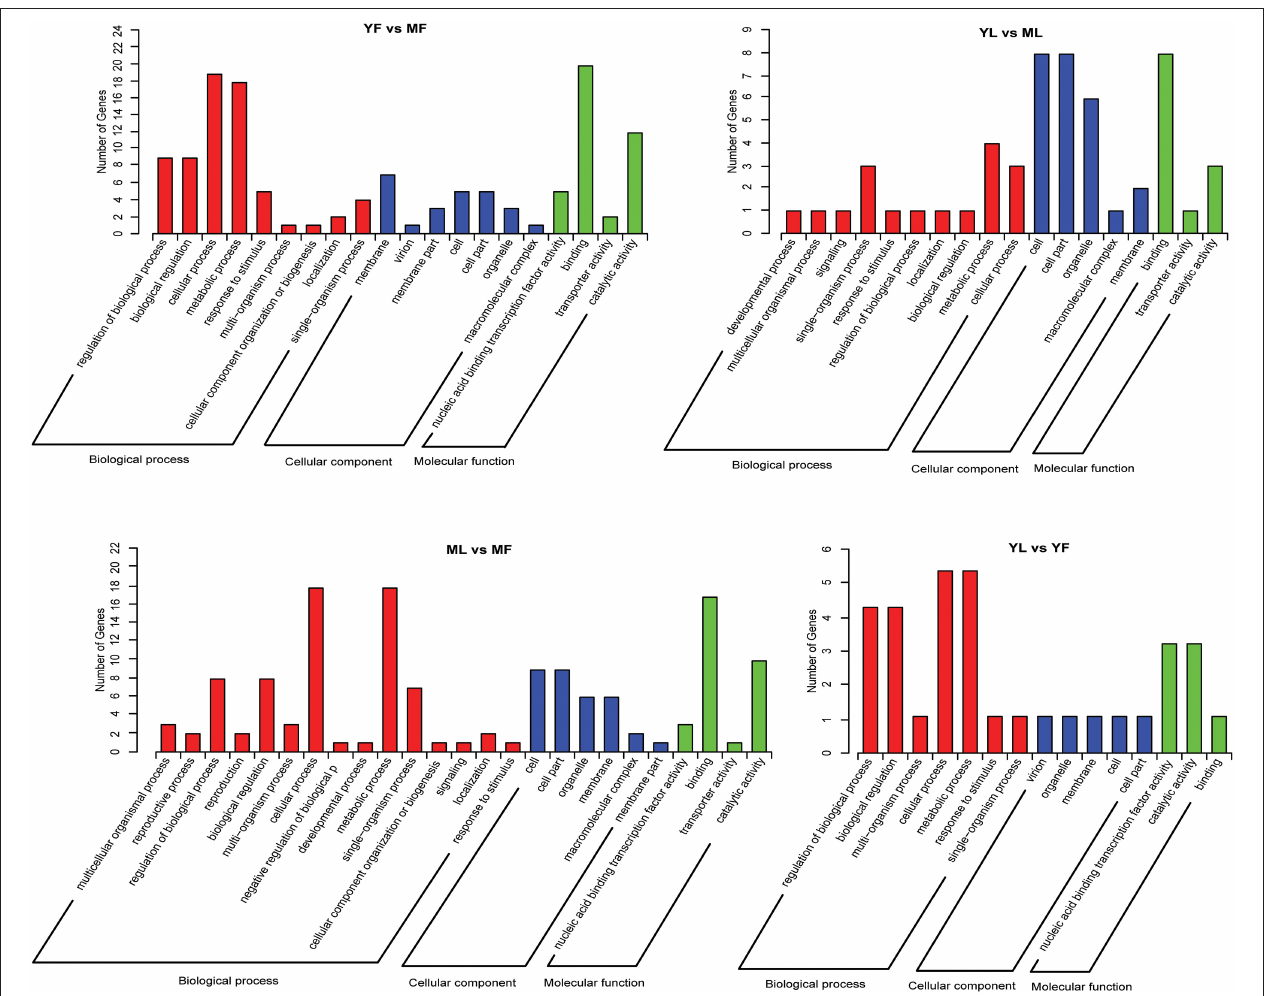
FIGURE 3 | Gene ontology (GO) enrichment analysis of target genes for the differentially expressed miRNAs in Eucommia